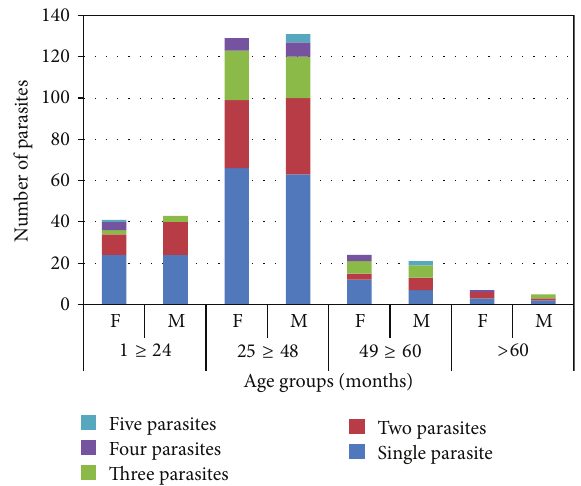
Figure 3: Patterns of single, double, and polyparasitisms among children participants in each age